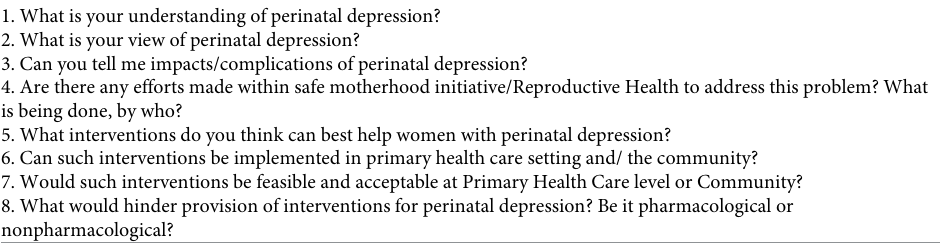
Table 2. A summary of interview guide for health workers and maternal coordinators.